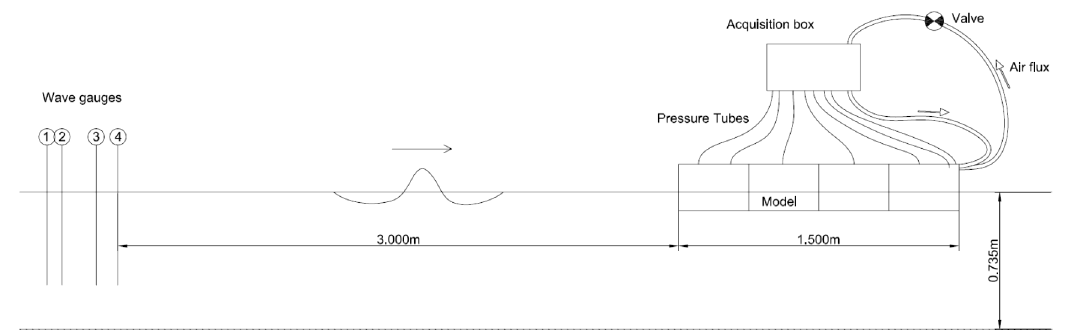
Figure 14. The closed model setup with measuring system.